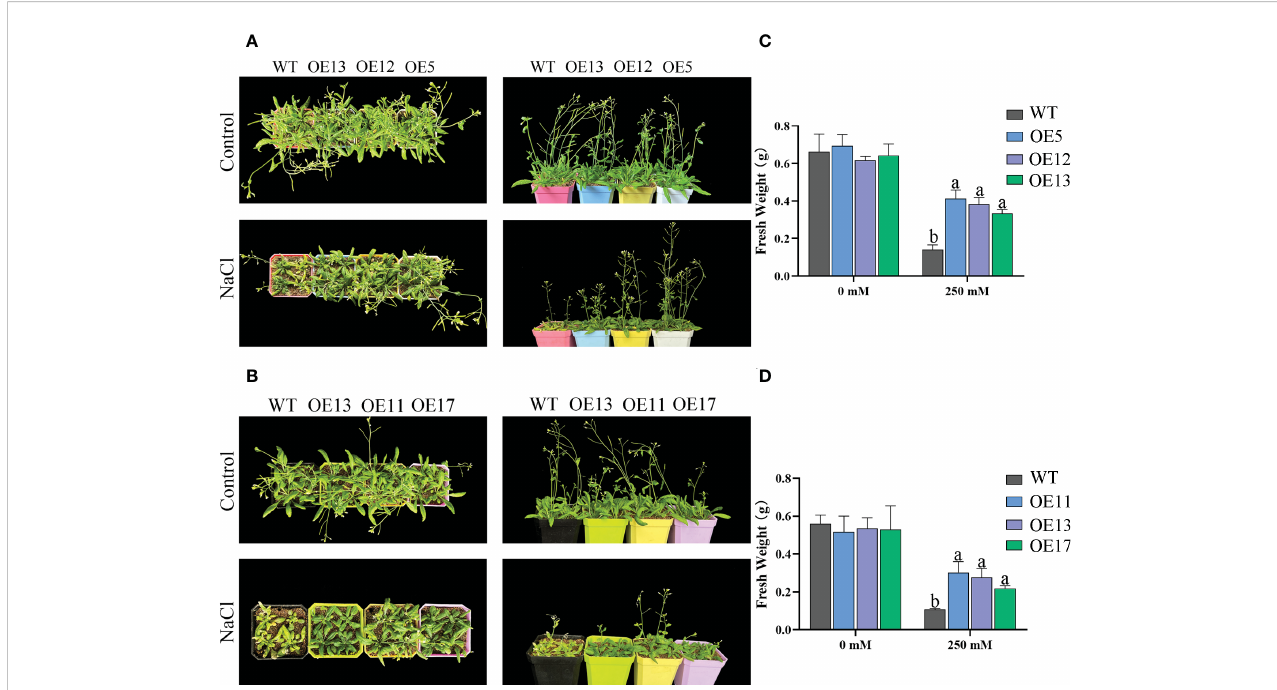
FIGURE 8 Improved salt tolerance in transgenic Arabidopsis plants expressing CeqHAK6 and CeqHAK11 . (A) Performance of CeqHAK6 transgenic and WT plants before and after salt treatment. (B) Performance of CeqHAK11 transgenic and WT plants before and after salt treatment. All Arabidopsis seedlings were treated with 250 mM NaCl for 10 days. (C) Fresh weight of CeqHAK6 transgenic and WT plants before and after salt treatment. (D) Fresh weight of CeqHAK11 transgenic and WT plants before and after salt treatment. The signi fi cant differences identi fi ed using Duncan ’ s Multiple Range Test ( p <0.05) were denoted by different lowercase letters on the top of